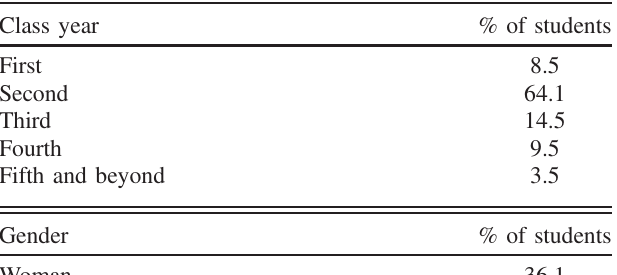
TABLE I. Self-reported demographic data of 407 students enrolled in the Fall 2020 semester of the CU Boulder PHYS 1140 Experimental Physics I